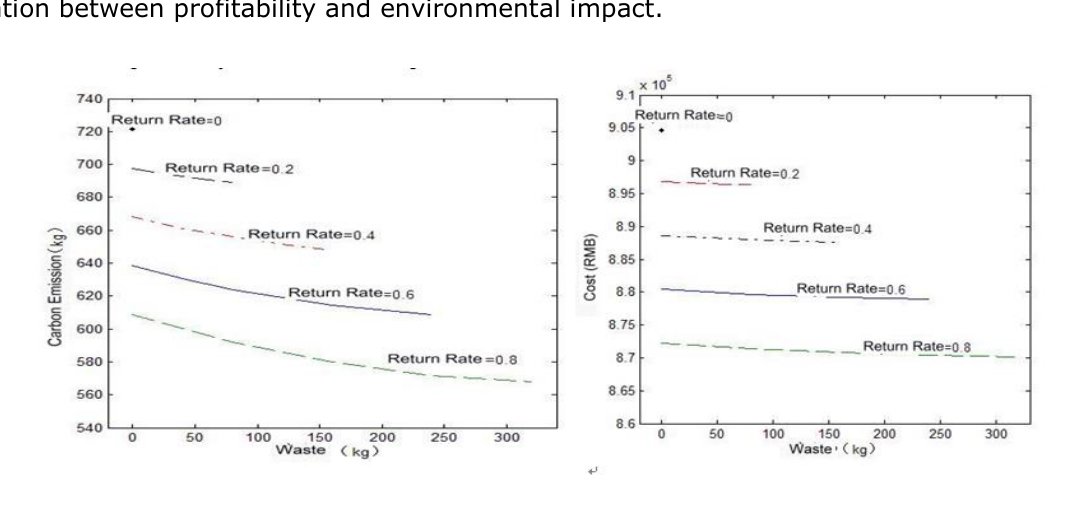
Figure 4. The Pareto Boundaries with Different Return Rates